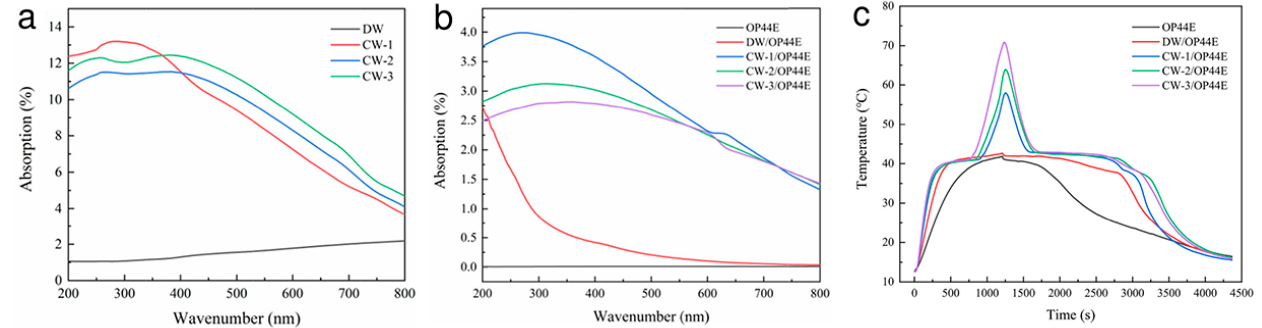
Figure 11. ( a , b ) The absorption graphs of carbonized wood samples, DW/OP44E and CW-OP44E and ( c ) photothermal behavior of the samples. DW stands for delignified wood and CW stands for carbonized wood and OP44E is supporting paraffin material. Reproduced with permission from reference [57], copyright 2021, Elsevier B.V.